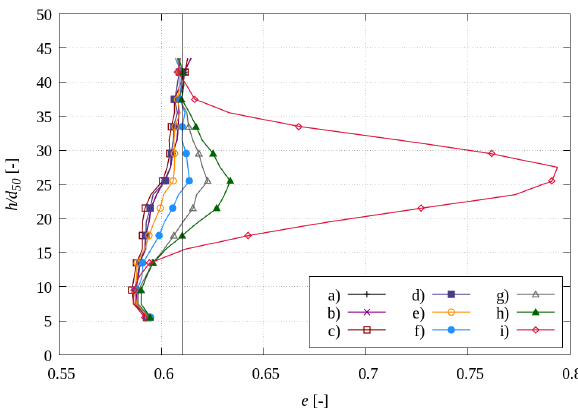
Figure 22: Distribution of void ratio e across the normalized specimen height h / d at the specimen centre for: a) u = 0.25 50 x mm, b) u = 0.50 mm, c) u = 0.75 mm, d) u = 1.00 mm, e) u = 1.25 x x x x mm, f) u = 1.50 mm, g) u = 1.75 mm, h) u = 2.00 mm and i) u = x x x x 10.00 mm ( e = 0.60, σ = 200 kPa, d = 0.5 mm) (dark vertical line 0 0 50 demonstrates 5% limit).